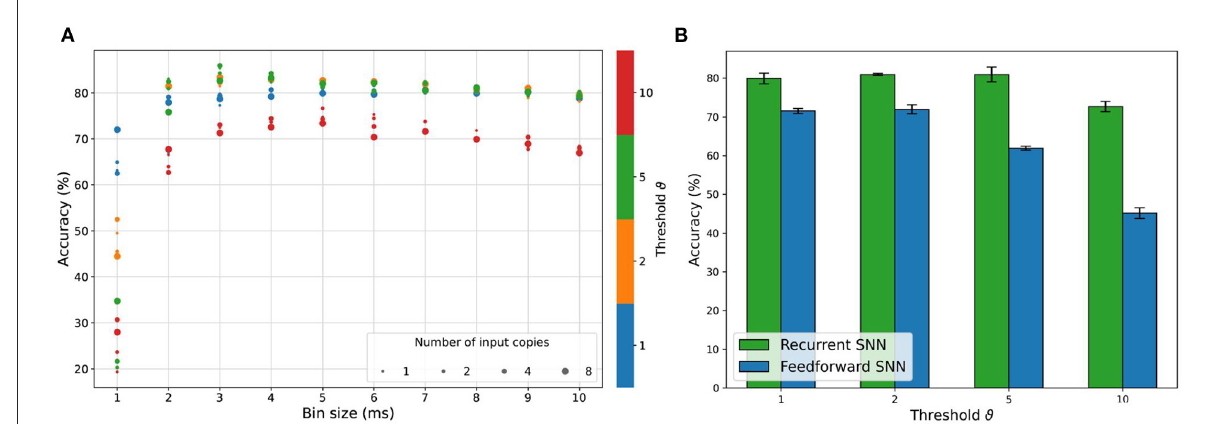
FIGURE7 Summary of the accuracy performances of RSNN and FFSNN resulting from the grid search exploration in the two-step HPO procedure. (A) Best test accuracy results achieved with the RSNN for all the combinations of time _ bin _ size and nb _ input _ copies . (B) Mean and standard deviation of the accuracy results of both the FFSNN and the RSNN with the best parameters for each encoding threshold.